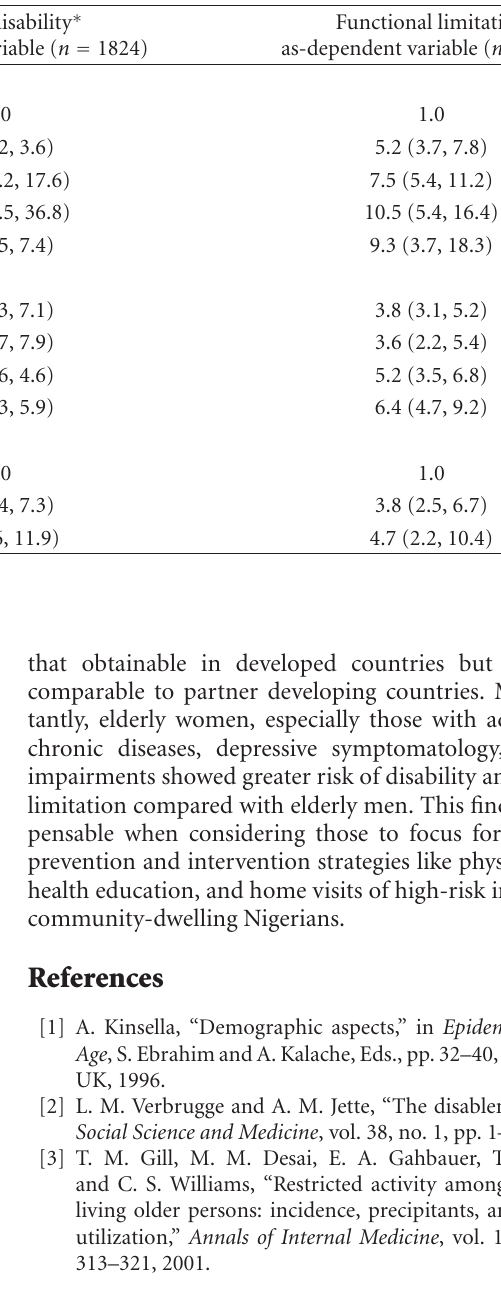
Table 5: Adjusted prevalence ratios for associations between sociodemographic and health related variables and poor physical function among elderly rural